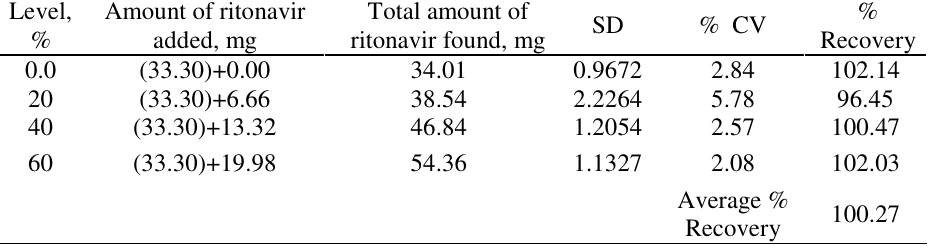
Table 4. Results from recovery analysis for ritonavir (n=5)